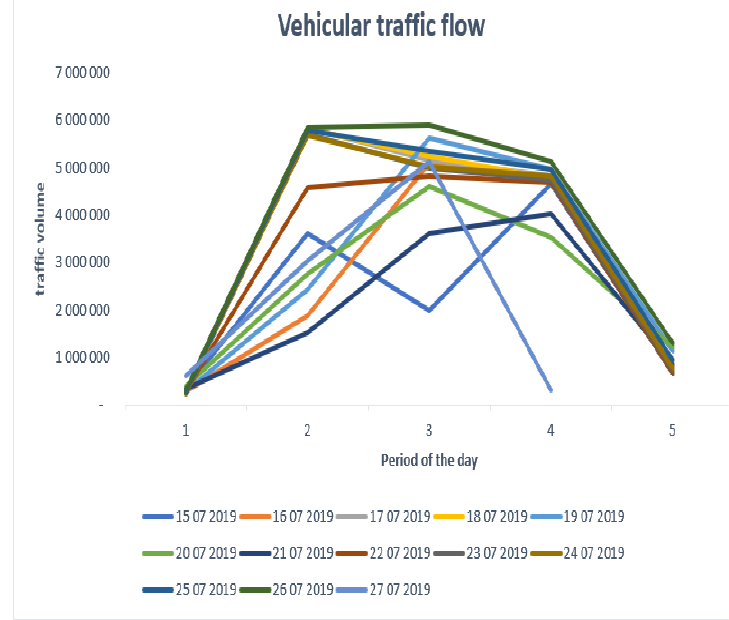
Figure 9. Road intersection 1.